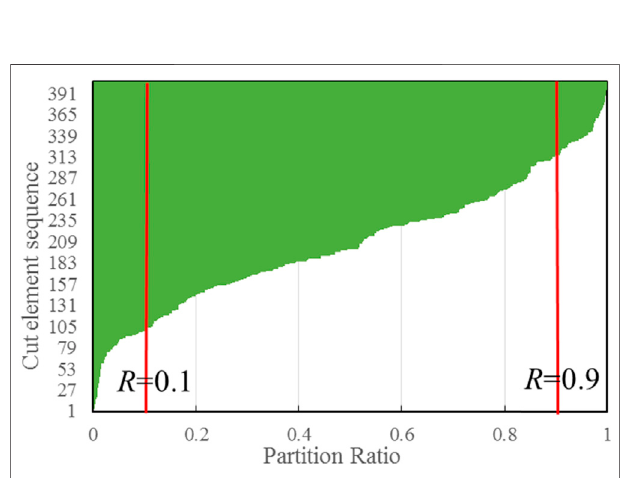
FIGURE 16 | Distribution of unstructured mesh partition ratios.